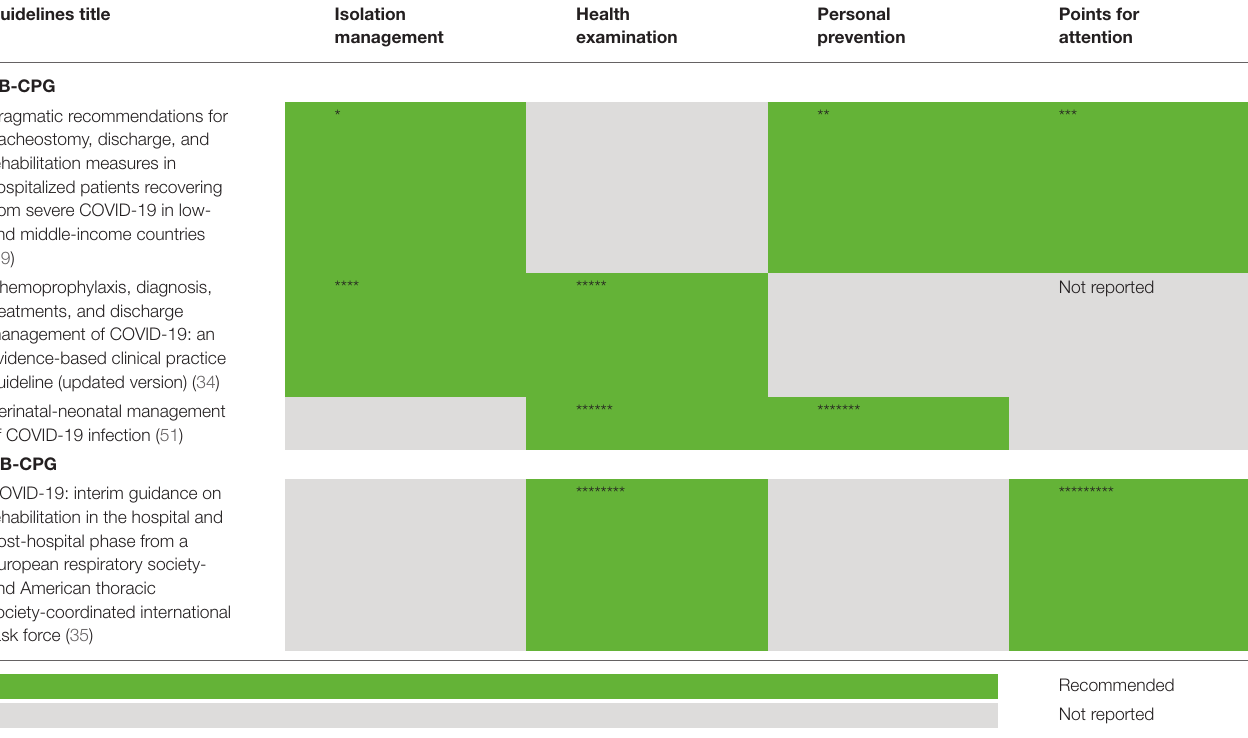
TABLE 5B | Recommendations on precautions after discharge of